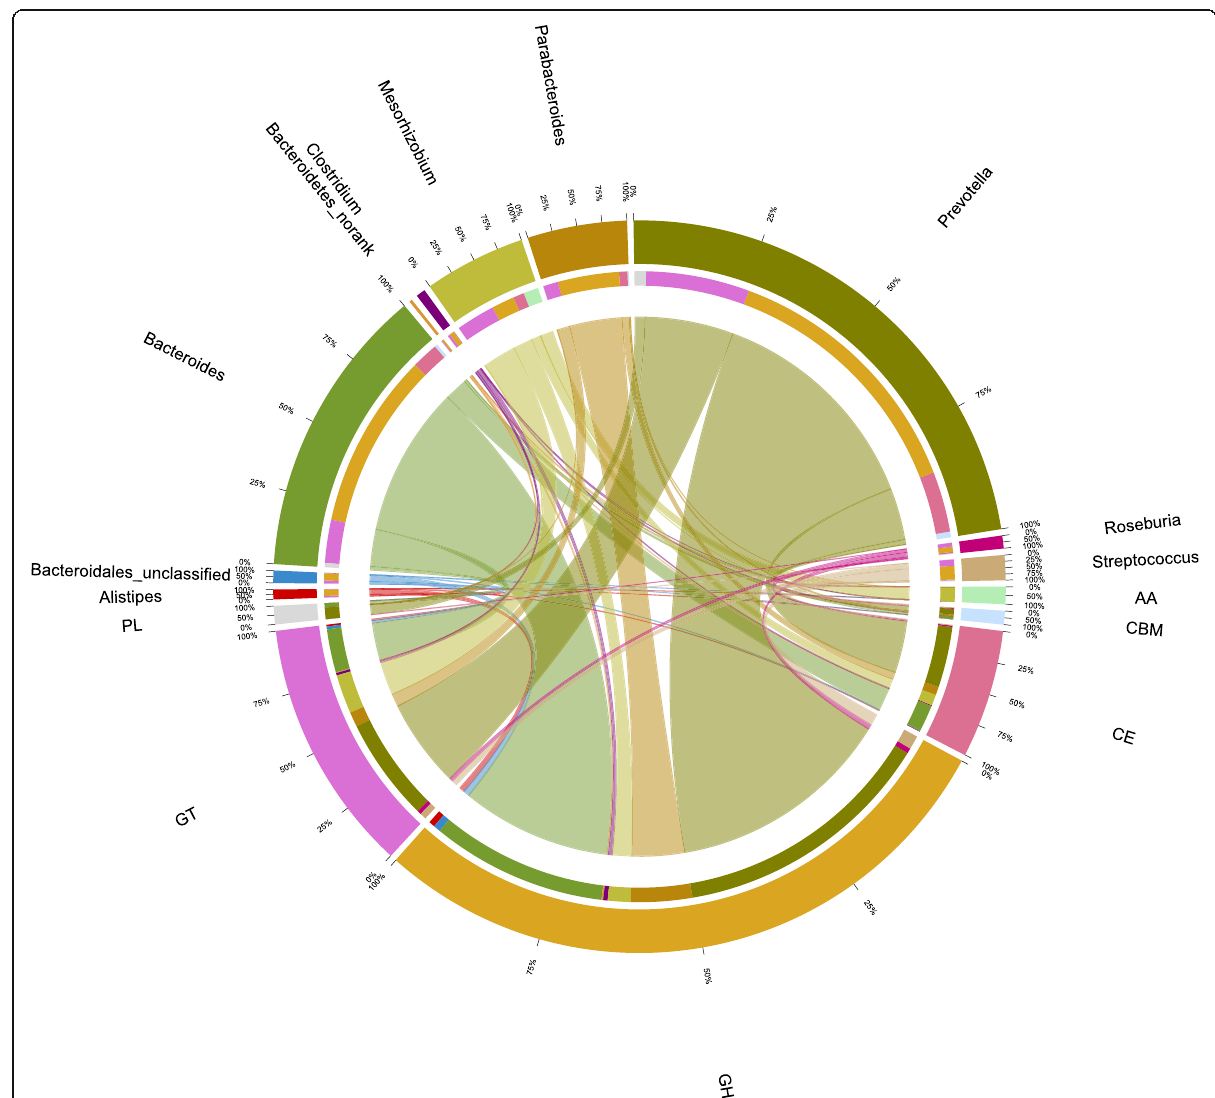
Fig. 8 Taxonomic distribution (genus level) of the predicted CAZymes identified from the metatranscriptomes in the PEC group. The CAZyme families and the corresponding genus are shown on the sides above and below, respectively. The inner ring designates the total number of unigenes encoding a given CAZyme class (below) and the total number of CAZymes associated with the given genus, while the outermost ring designates the relative abundance of a given CAZyme family (below) and the relative abundance of unigenes from a given genus (above). The width of the bars between a given genus and a given CAZyme family indicates their relative abundance compared with that in other